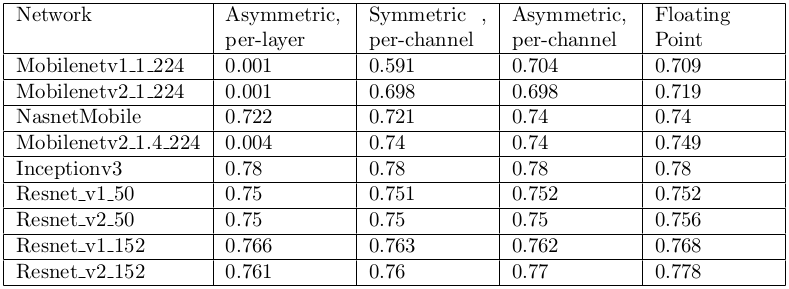
Table from the paper: Quantizing deep convolutional networks for efficient inference: A whitepaper
Table text:
Network
Asymmetric,
per-layer
Symmetric ,
per-channel
Asymmetric,
per-channel
Floating
Point
Mobilenetv11224
0.001
0.591
0.704
0.709
Mobilenetv21224
0.001
0.698
0.698
0.719
NasnetMobile
0.722
0.721
0.74
0.74
Mobilenetv21.4224
0.004
0.74
0.74
0.749
Inceptionv3
0.78
0.78
0.78
0.78
Resnetv150
0.75
0.751
0.752
0.752
Resnetv250
0.75
0.75
0.75
0.756
Resnetv1152
0.766
0.763
0.762
0.768
Resnetv2152
0.761
0.76
0.77
0.778